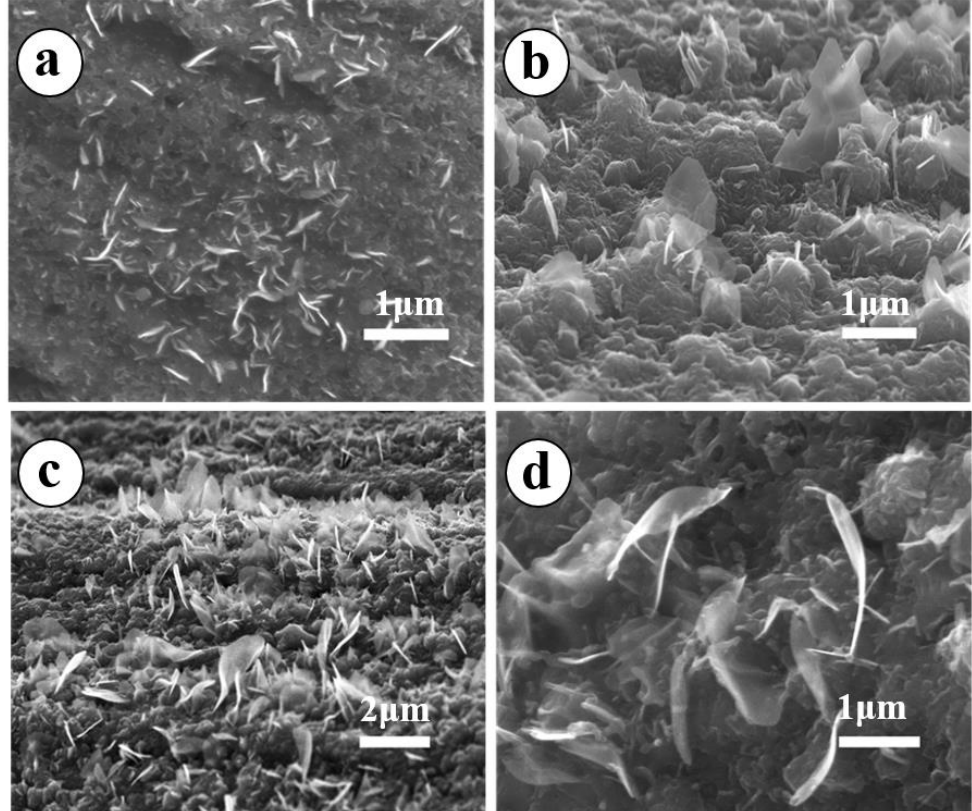
Figure 2. Scanning electron microscopy (SEM) images of MONs grown on the stainless steel at ( a ) 1000 °C; ( b ) 1050 °C; and ( c ) 1100 °C for 5 min each; ( d ) An enlarged view of ( c ).